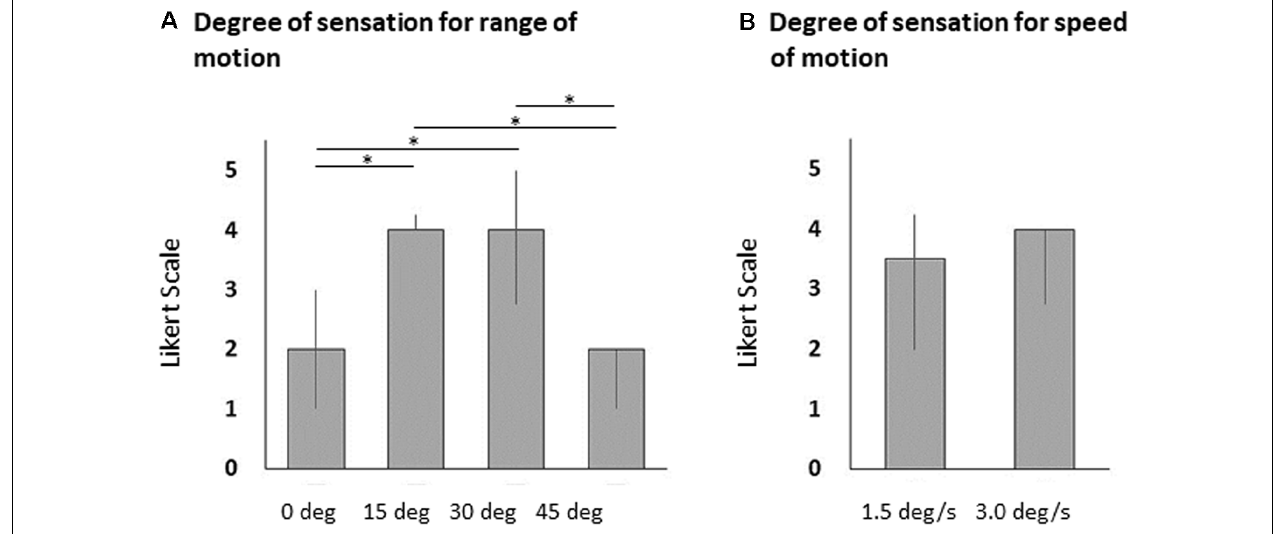
FIGURE 2 | Bar graphs of the illusory sensations for wrist flexion angle (A) and flexion speed (B) . The columns and error bars denote the median and interquartile range, respectively. The illusory sensations of wrist flexion angles at 15 ◦ and 30 ◦ were significantly higher than those at 0 ◦ and 45 ◦ (Friedman’s test, ∗ p < 0.0001 and Steel–Dwass test, 0 ◦ vs. 15 ◦ , ∗ p < 0.0001, 0 ◦ vs. 30 ◦ , ∗ p < 0.0001, 15 ◦ vs. 45 ◦ , ∗ p < 0.0001, 30 ◦ vs. 45 ◦ , ∗ p < 0.0001). However, the illusory sensations of wrist flexion speeds were small and were not significantly different between 1.5 ◦ /s, and 3.0 ◦ /s (Wilcoxon signed-rank test, p = 0.620).